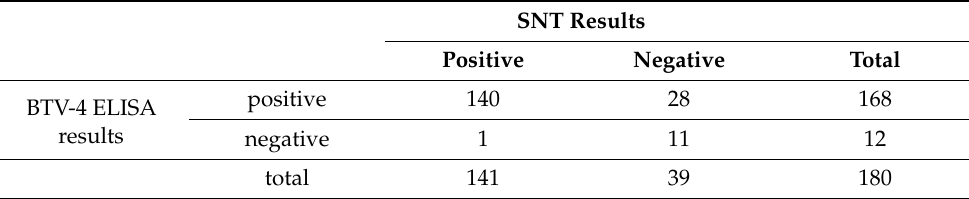
Table 2. BTV-4 ELISA and SNT-4 results from 180 vaccinated